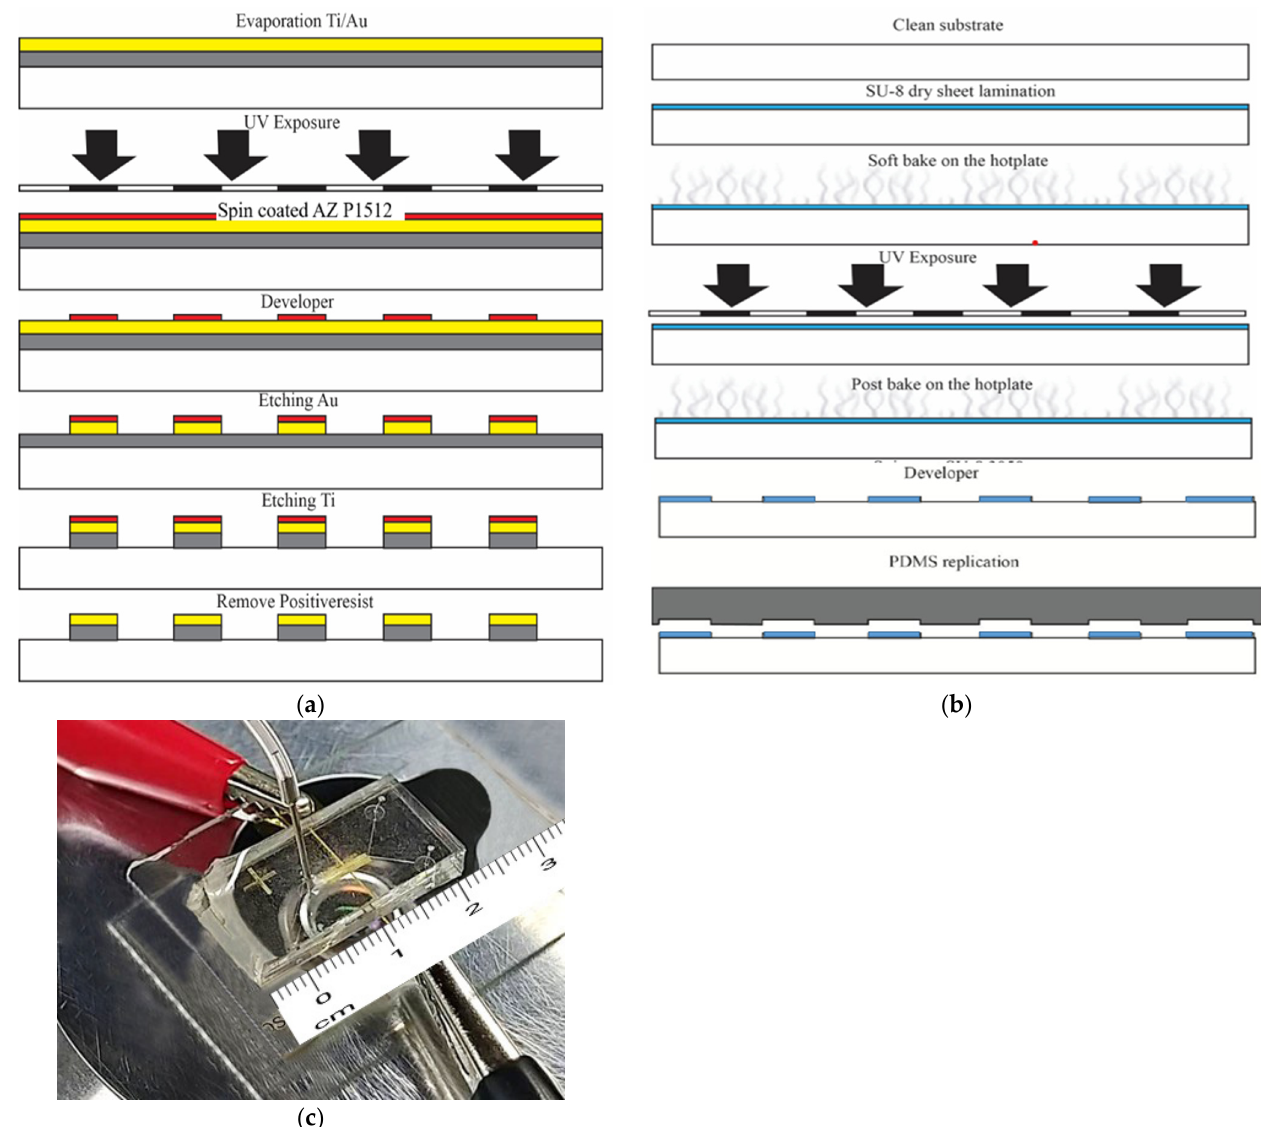
Figure 4. Illustration of the microfluidic device fabrication process using ultraviolet and soft lithog- raphy. ( a ) Fabrication of the microelectrodes ( b ) fabrication of the microchannels and ( c ) Microflu- idic chip for thin film electrode.